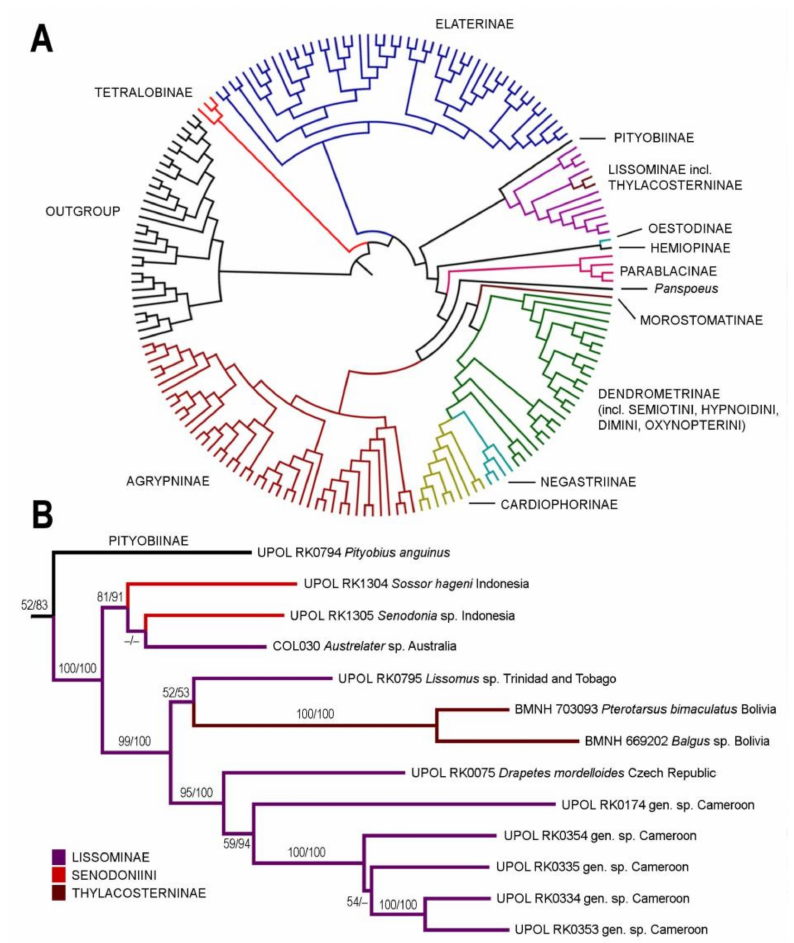
Figure 1. Phylogenetic position of Senodonia and Sossor . ( A ) Phylogenetic hypothesis for Elateridae based on the 183 terminals aligned by MAFFT and analyzed by maximum likelihood using RAxML. Detailed information on the terminals used is given in Kundrata et al. [6]; ( B ) phylogeny of the Lissominae + Thylacosterninae complex. Numbers at branches represent bootstrap support and Bayesian posterior probabilities,